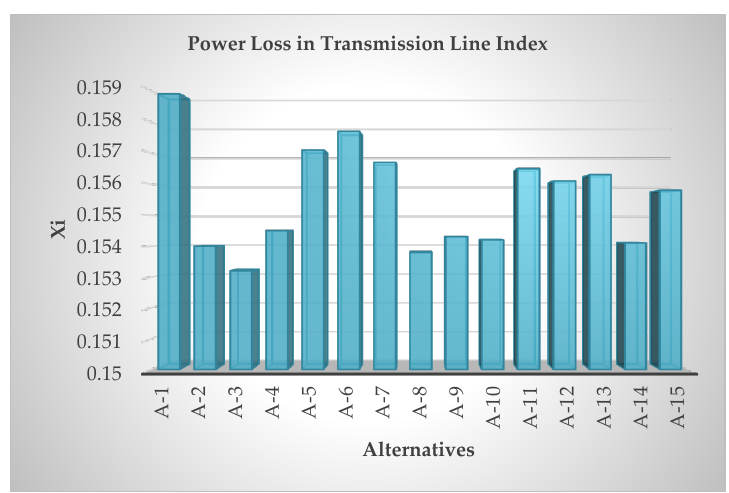
Figure 11. Power loss in transmission line index of each alternative. Energies 2018 , 11 , x FOR PEER REVIEW